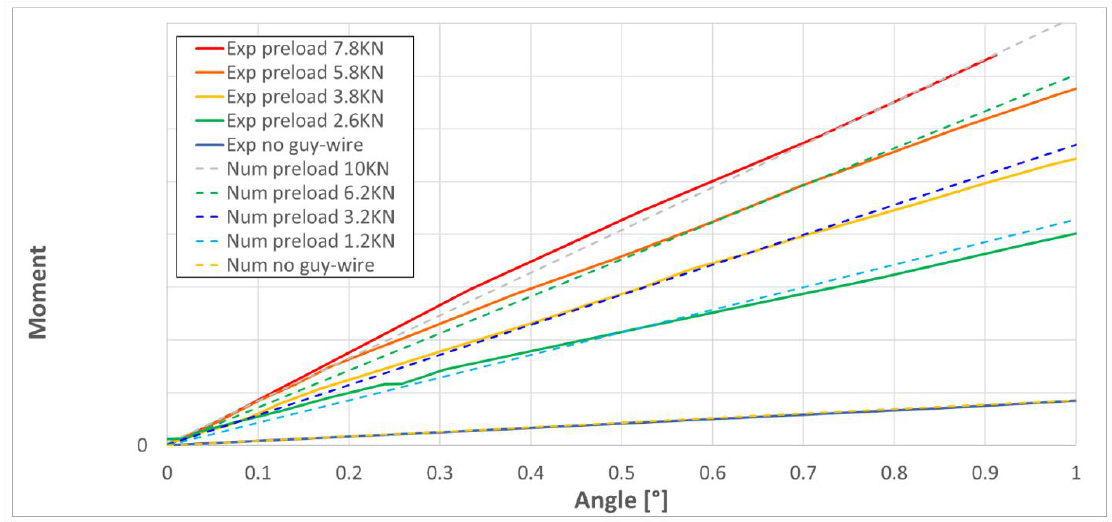
Energies 2021 , 14 , x FOR PEER REVIEW 25 of 27 Figure 23. Overview of the FE model with the guy-wire configuration B1 (top), detail of the gripping device applied on the traverse, with the mesh (centre), detail of the gripping device applied on the back beam, with the mesh (bottom).